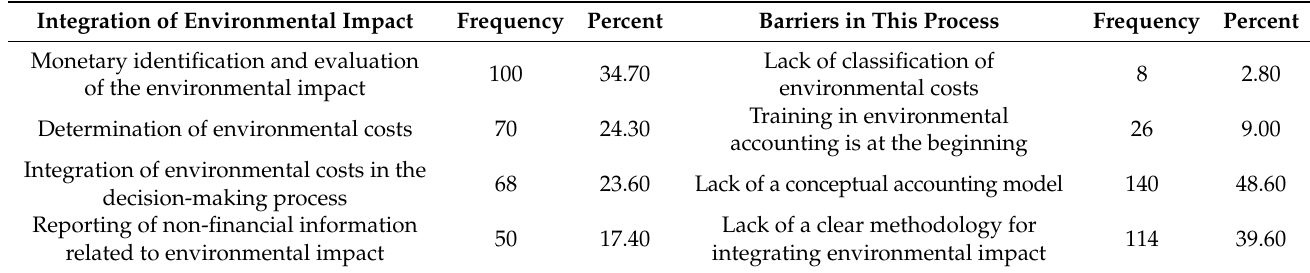
Table 7. Integration of environmental impact, barriers in this process.